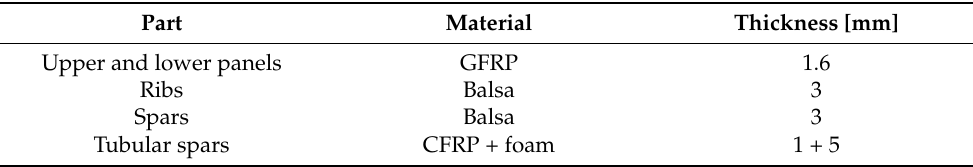
Table 3. Material properties.